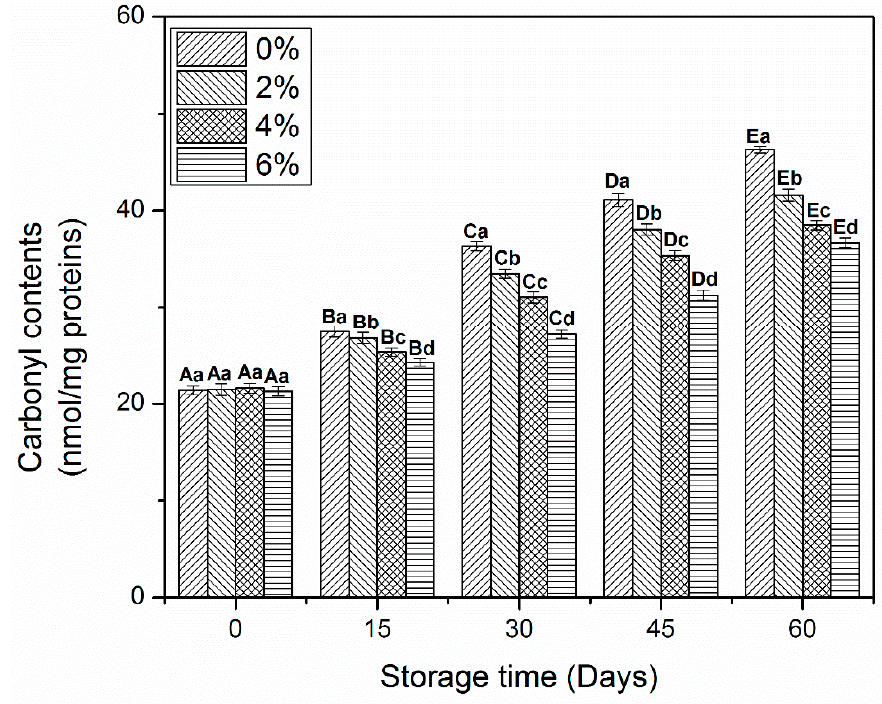
Figure 1. Carbonyl contents of myofibrillar protein treated with different concentrations of OVA-KC during 60 days of frozen storage at − 18 °C. Capital letters (A–E) refers to the significant differences in similar treatments within the different storage times ( p < 0.05). Lowercase letters (a–d) refers to the significant difference in the same frozen storage period of different concentrations ( p < 0.05).